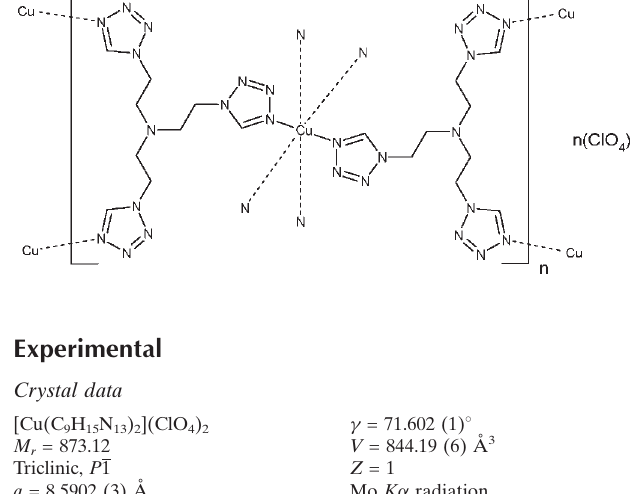
Bruker SMART APEX CCD diffractometer Absorption correction: multi-scan ( SADABS ; Bruker, 2003) T min = 0.86, T max = 1.00